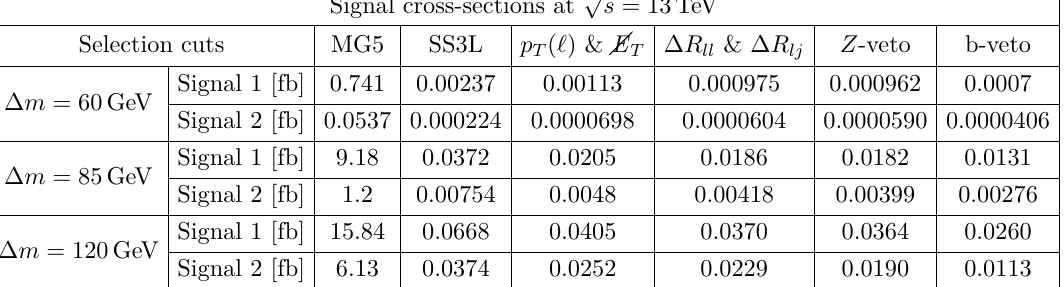
√ s = 13 TeV LHC for the = m and m 2 is properly A H ± 12